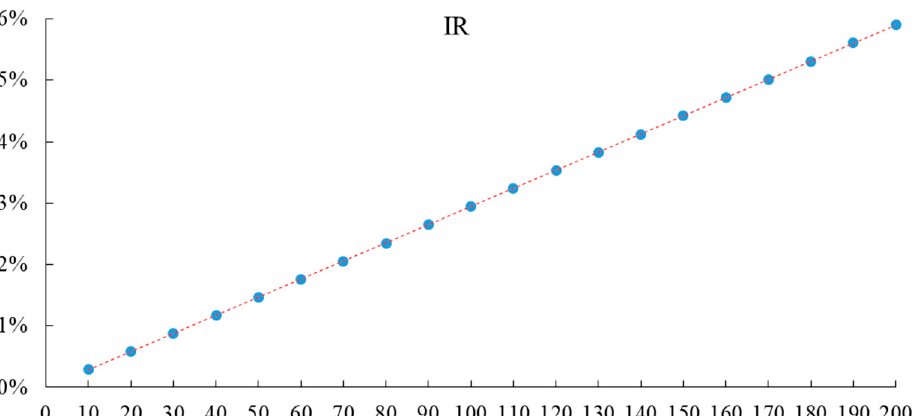
Figure 2. Different carbon tax rates and inflation rates.